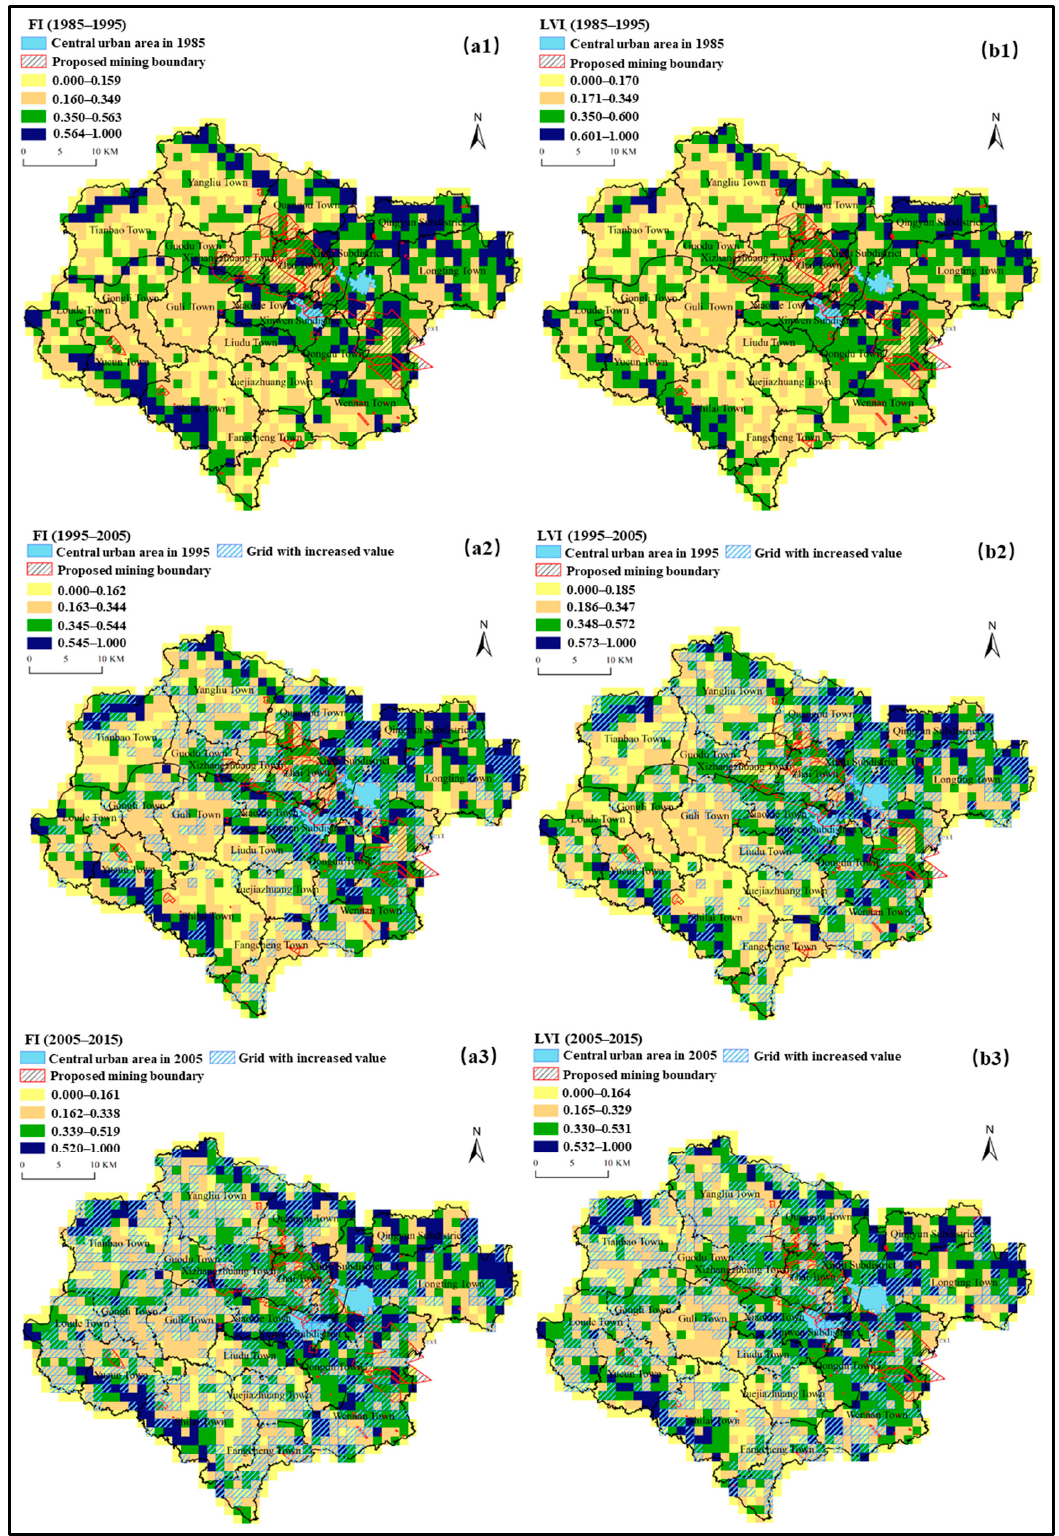
Figure 7. Temporal–spatial distribution of cultivated land FI and LVI. ( a1 ) fragmentation index (FI) in 1985–1995. ( a2 ) fragmentation index (FI) in 1995–2005, ( a3 ) fragmentation index (FI) in 2005–2015. ( b1 ) landscape vulnerability index (LVI) in 1985–1995. ( b2 ) landscape vulnerability index (LVI)